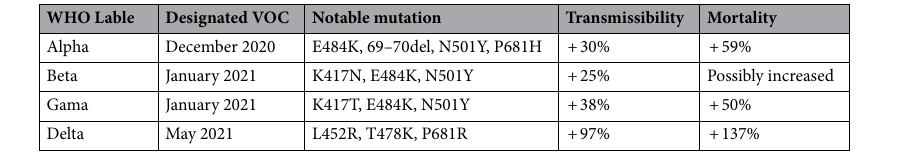
Table 2. Major global SARS-CoV-2 variants of concern 63–66 .